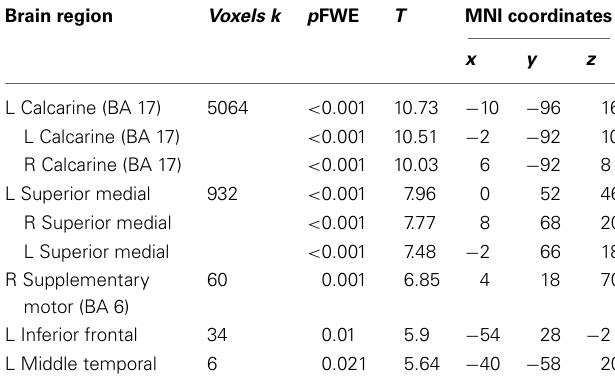
Table 4 | Brain regions with significant BOLD activations to baseline > correct stops.